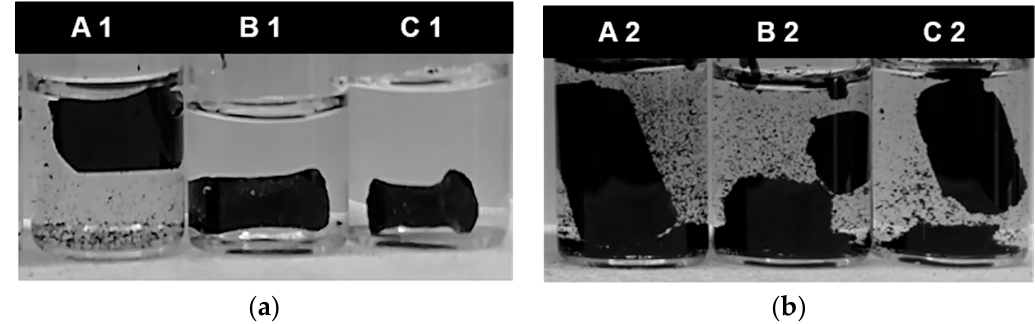
Figure 5. Solubility of cylindrical monoliths in DI-water synthesized with different US duration (A: 0 min, B: 3 min, C: 6 min), dried at 60 °C for 72 h ( a ) (A1–C1), and freeze-dried for 48 h ( b ) (A2–C2). Pictures were taken after 1 min of incuba- tion.